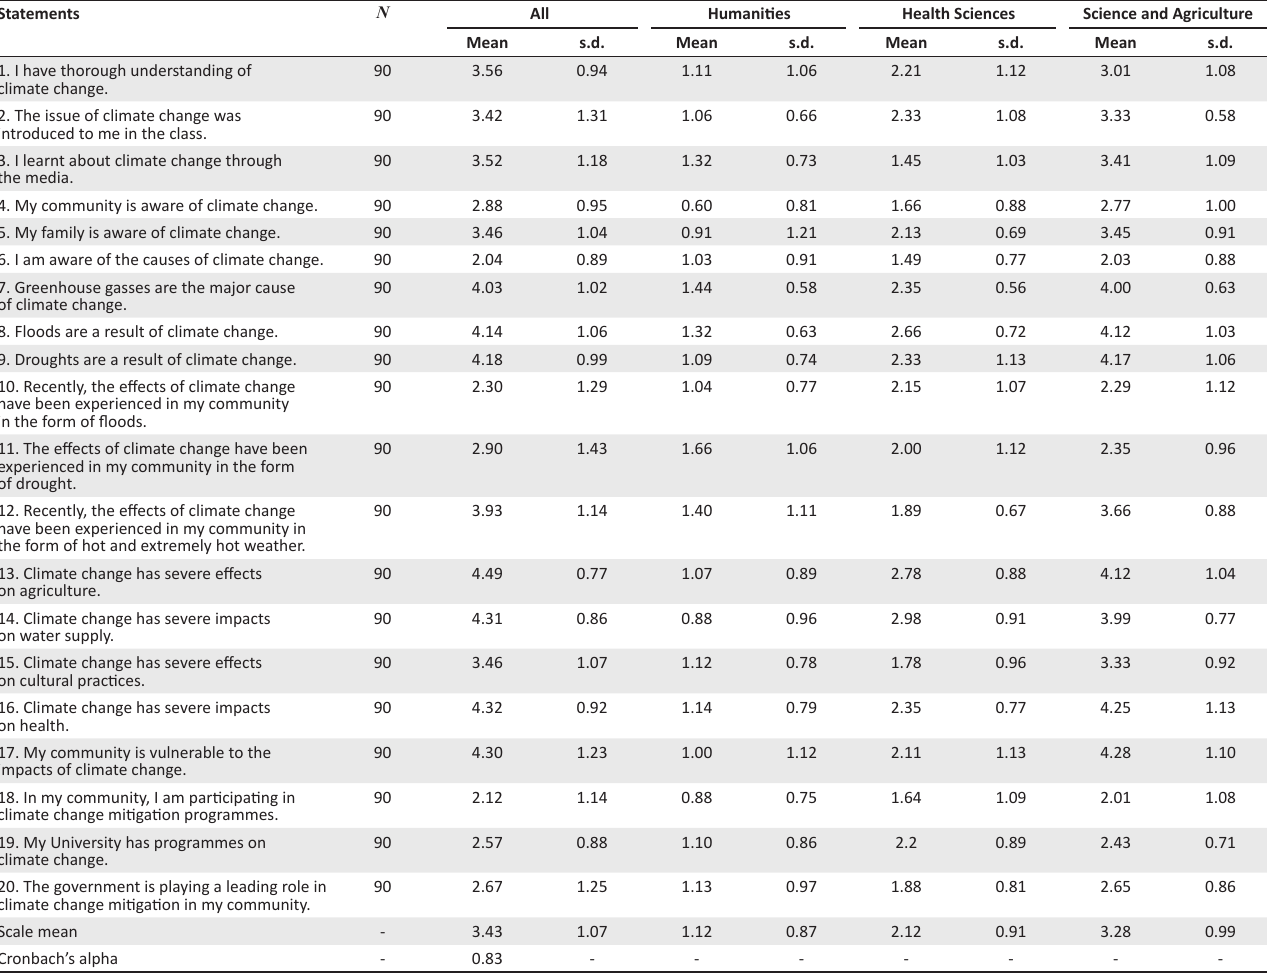
TABLE 2: Descriptive statistics for climate change variables.